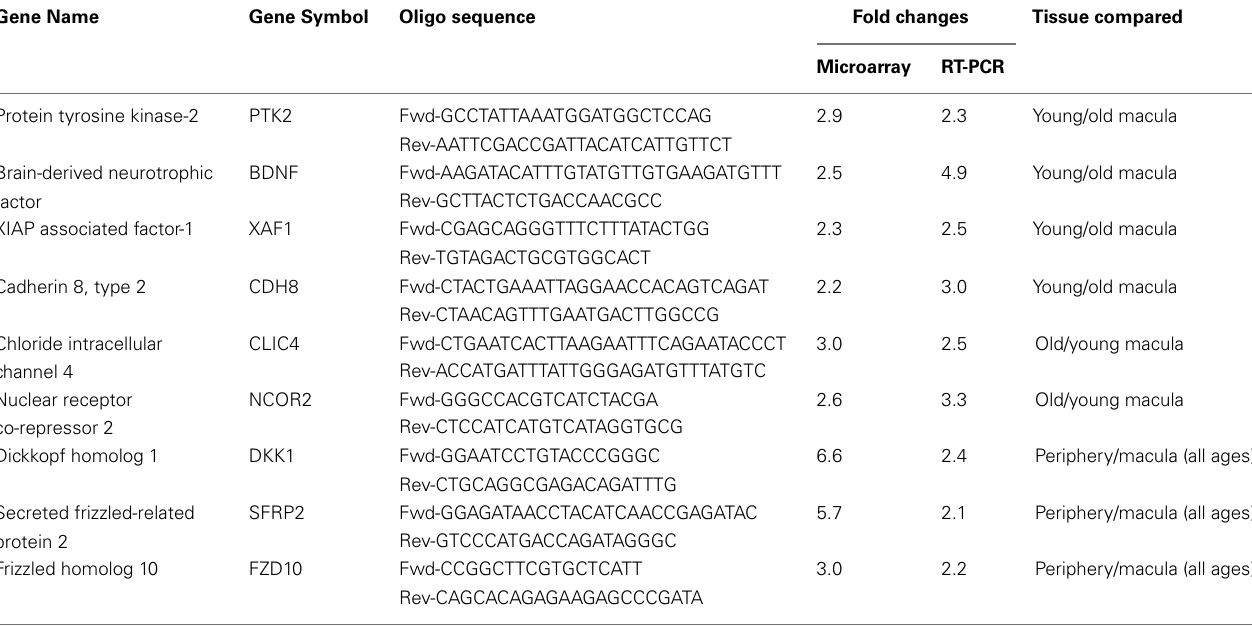
Table 2 | Primers used and the result of semi-quantitative RT-PCR compared to DNA